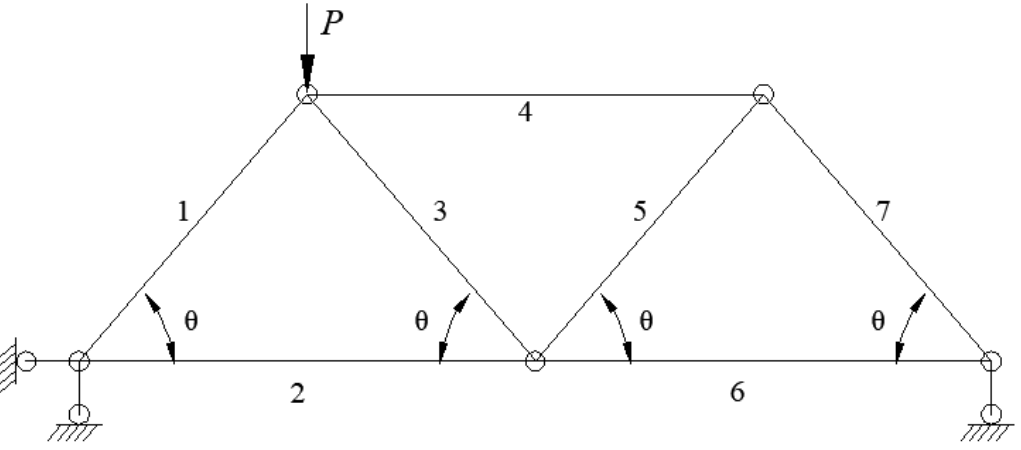
Figure 3. Truss beam subjected to external load effect ( P ).